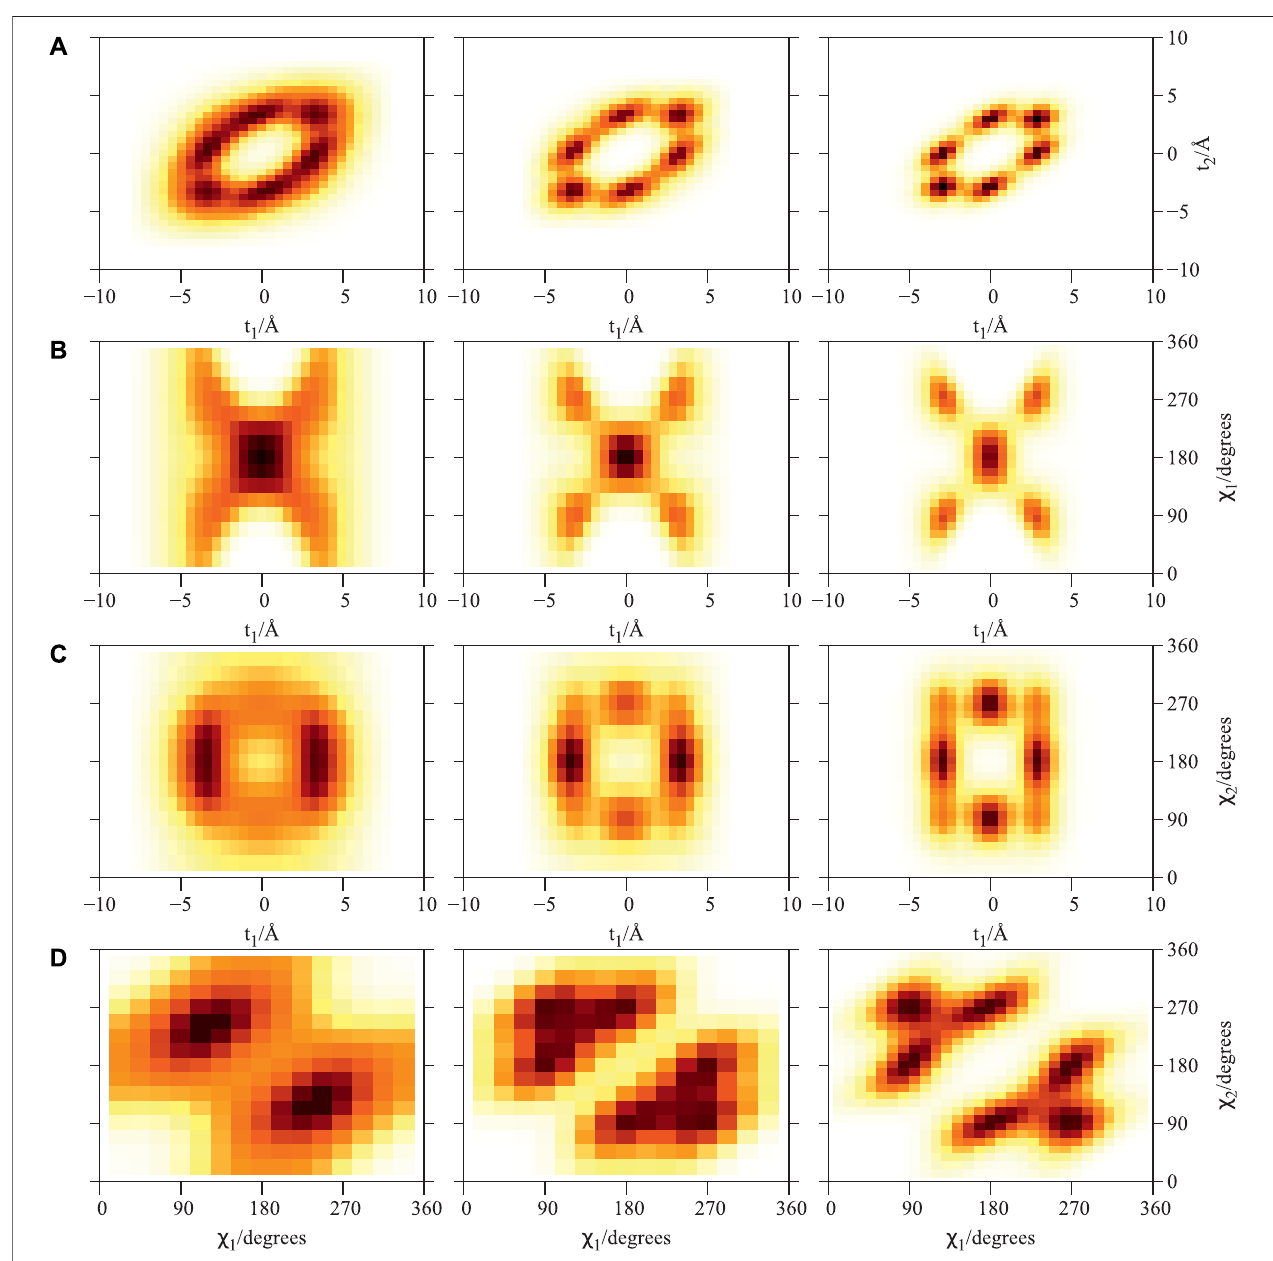
FIGURE2| Plot of2D densities fortheground stateofPN 4 ⊂ SWCNT(11, 4)complexes. Lefttoright: PN (cid:2) 4 He,para-H 2 ,ortho-D 2 . (A) t 1 and t 2 coordinates; (B) t 1 and χ 1 coordinates; (C) t 1 and χ 2 coordinates; (D) χ 1 and χ 2 coordinates. Source: (de Lara-Castells and Mitrushchenkov,